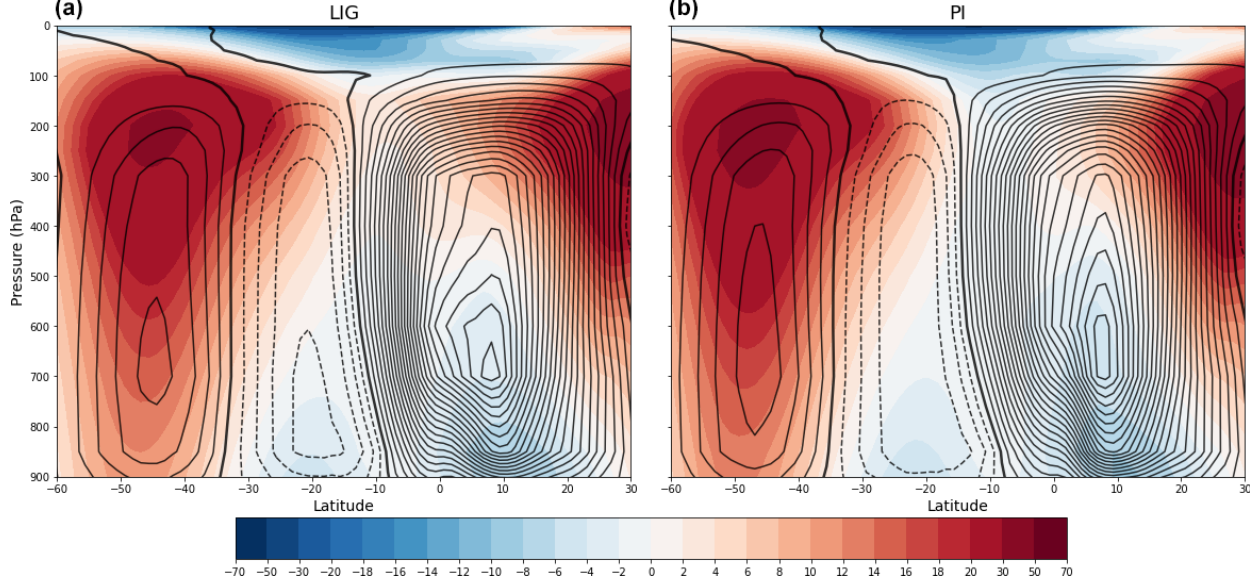
Figure 8. Atmospheric mass stream function in DJF, represented by solid (positive) and dashed (negative) contour lines, is contoured every 20Sv, with the bold lines being the zero contours. Zonal mean zonal winds (ms − 1 ) are represented by colour shading. (a) LIG. (b) PI. Note the shading interval is not